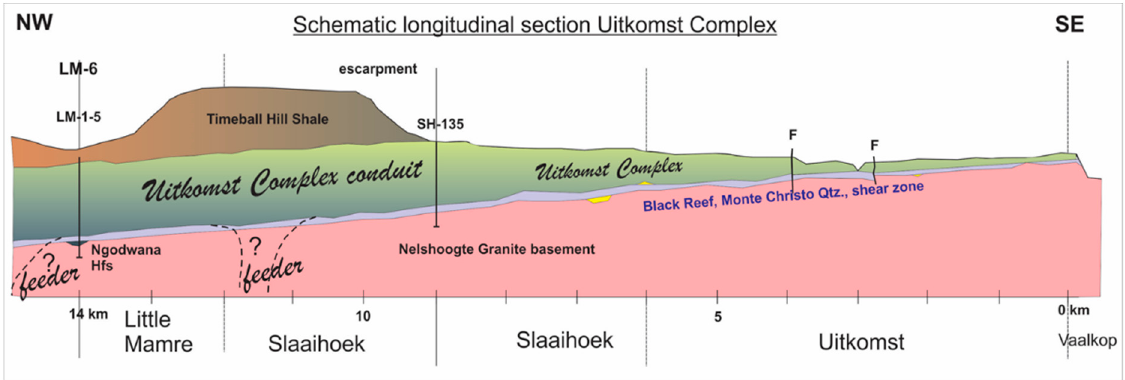
Figure 4. Idealised longitudinal section of the Uitkomst Complex from Vaalkop to Little Mamre. F: fault causing vertical displacement, Hfs: hornfels.